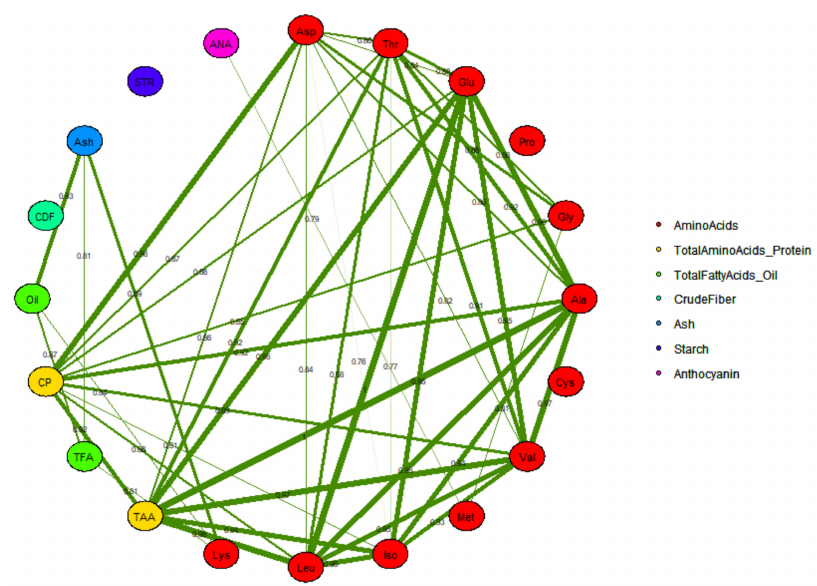
Figure 3. Blue maize grain compositional traits correlation network displaying the relationship between amino acids, total amino acids, total fatty acids, crude protein, oil, crude fiber, ash, starch, and anthocyanin. Abbreviations adapted for 20-grain compositional traits are shown in Table 1, and a total of 9 descriptor categories are used to display the relationship between amino acids, protein, oil, fiber, ash, starch, and anthocyanin. The number shown across each band represents the correlation coe ffi cient between compositional traits. The width of each band represents the strength of correlation among traits, and the specific color of each ellipse represents the descriptor category assigned to that trait, as shown in the figure legend. The traits included in the correlation network are abbreviated